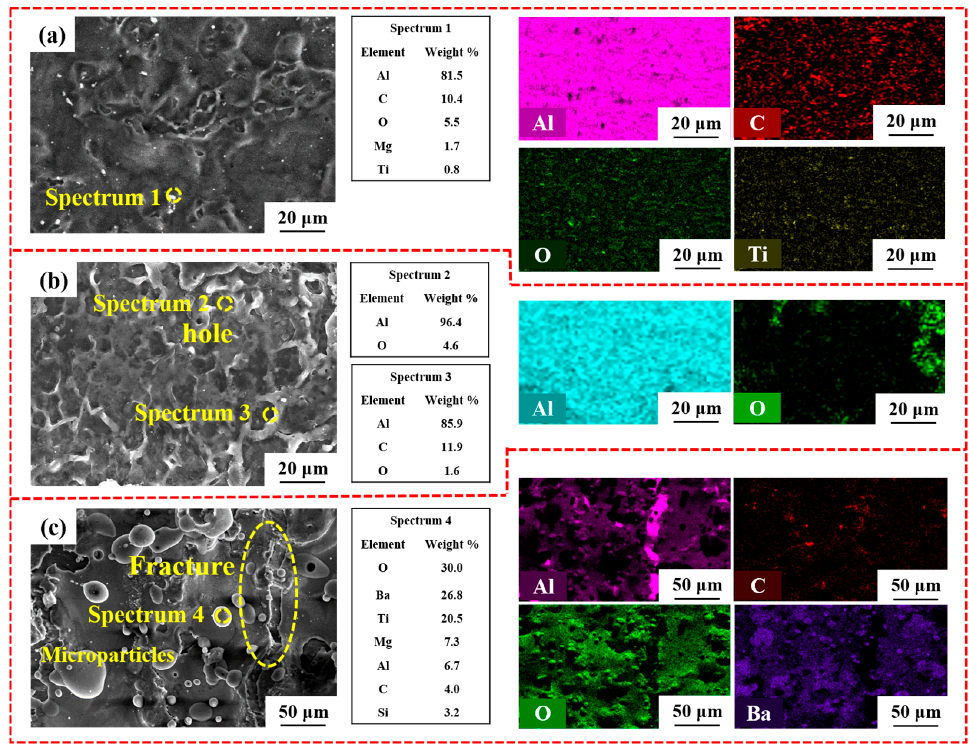
Figure 11. Microscopic SEM images, particle elements, and mapping of the surface after laser removal at laser removal parameters of specimens: ( a ) N-1 (12 J/cm 2 , 87.4%) ( b ) Y-1 (14.5 J/cm 2 , 87.6%) and ( c ) Y-2 (7 J/cm 2 , 96.5%).